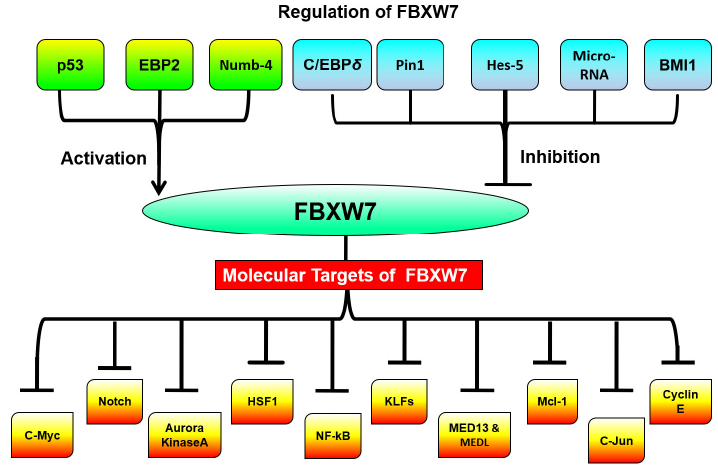
Figure 3. Regulators and targets of FBXW7 in cancer.